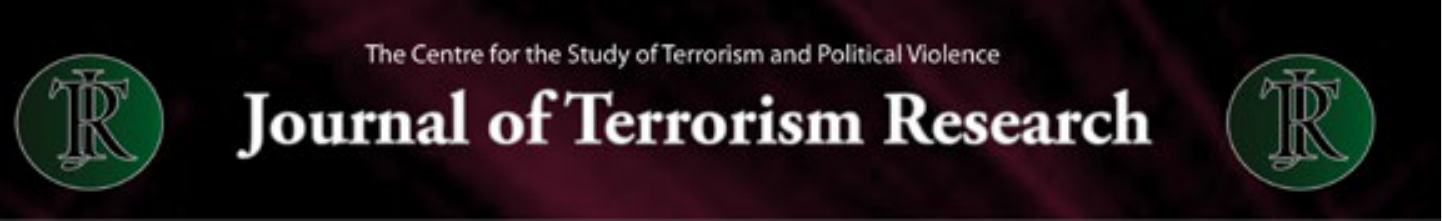
Table 3. Frequency of content-related concepts in the three tweet datasets. Frequency is expressed as a percentage of tweets containing the concept.